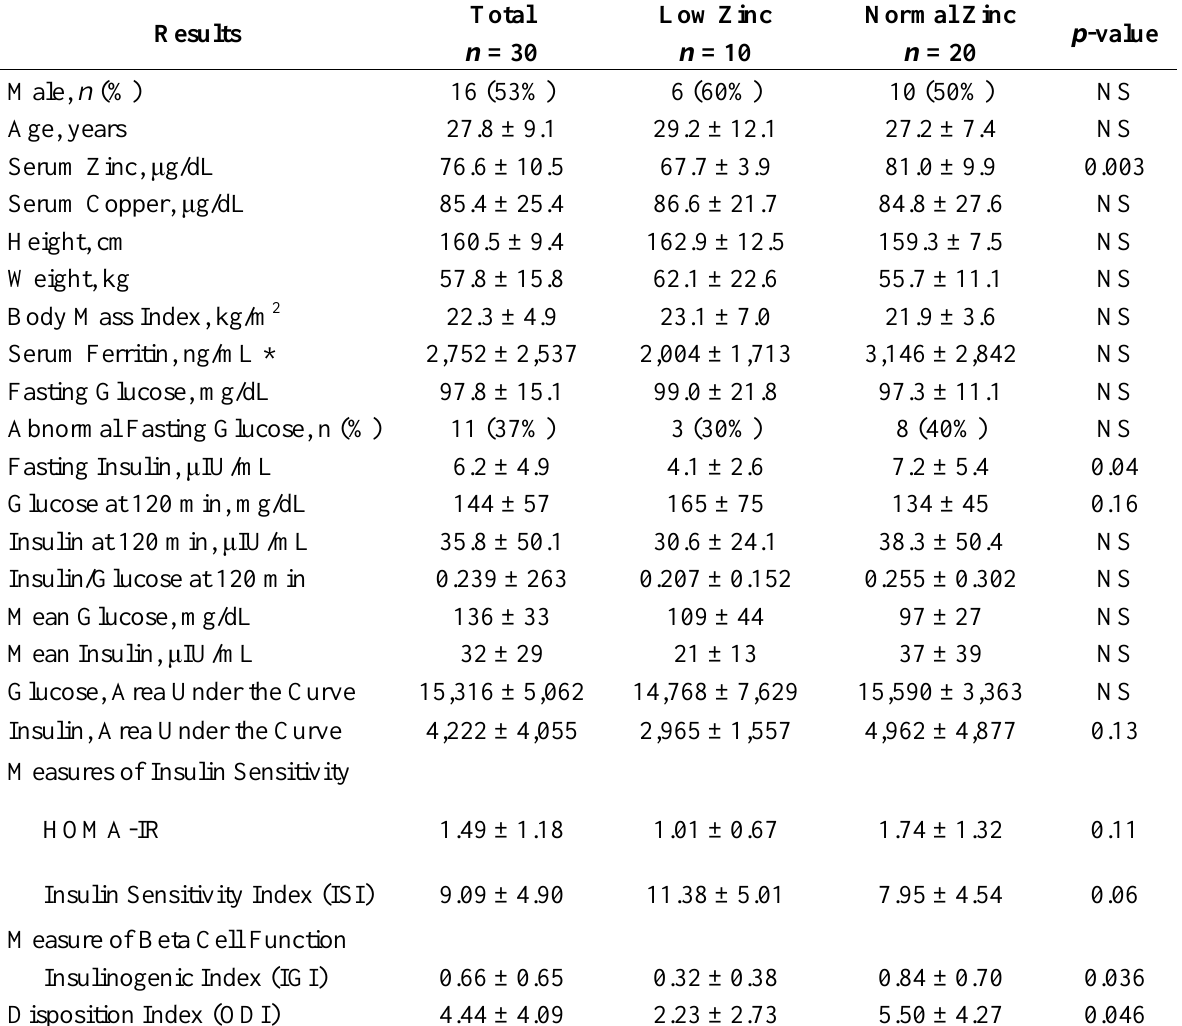
Table 1. Demographics and Basic Laboratory Results for 30 Subjects with Transfusion Dependent Thalassemia from a Clinical Oral Glucose Tolerance